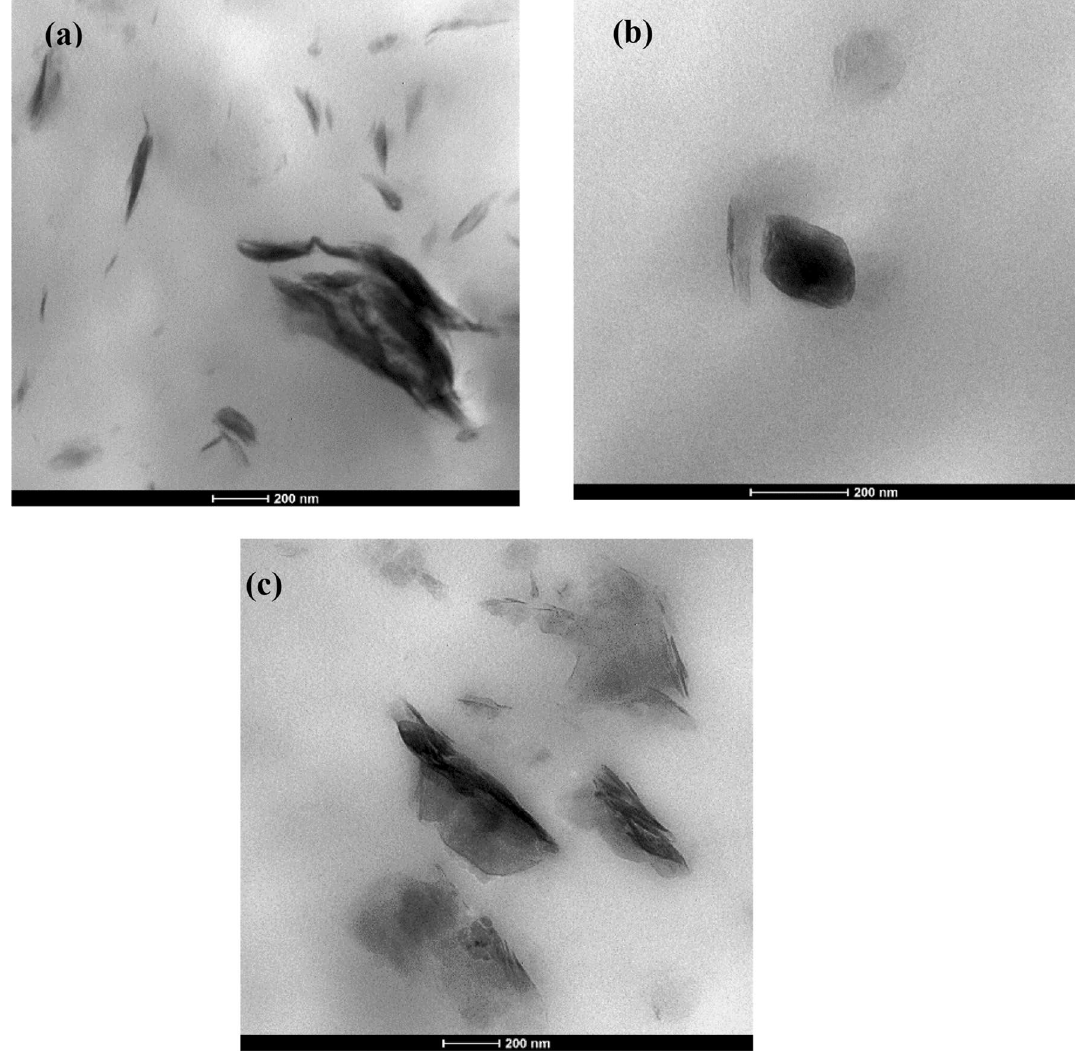
Fig. 7 TEM micrographs of the PP nanocomposites containing [BMMIM]Cl in the compositions: a 1.5 wt%; b 3.0 wt% and c 5.0